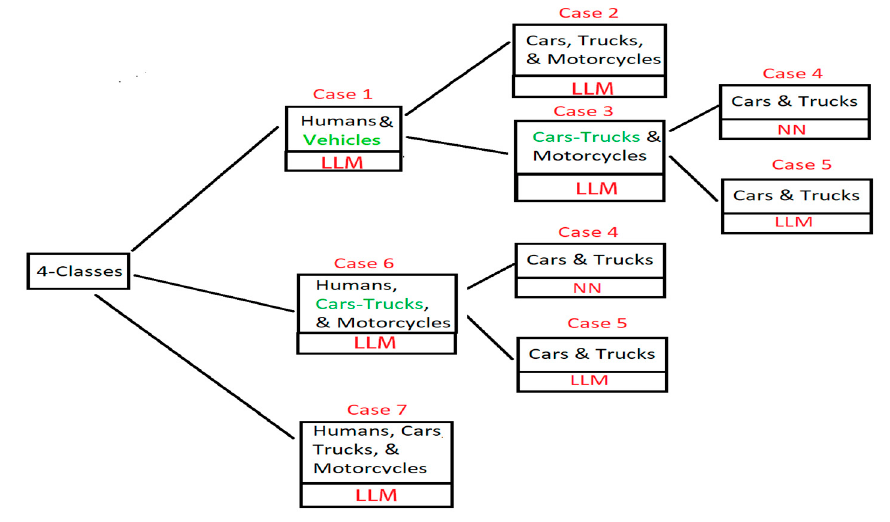
Figure 2. Cases 1–7 featuring all applied forecasts presented in this article.